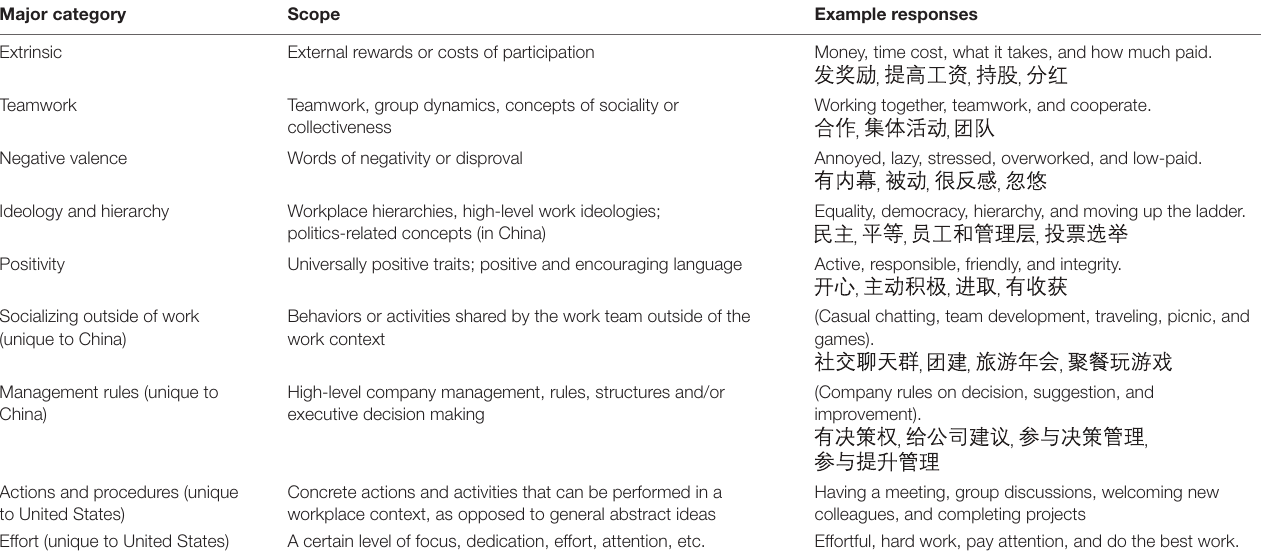
TABLE 1 | Major categories of associations with workplace participation in American and Chinese samples.